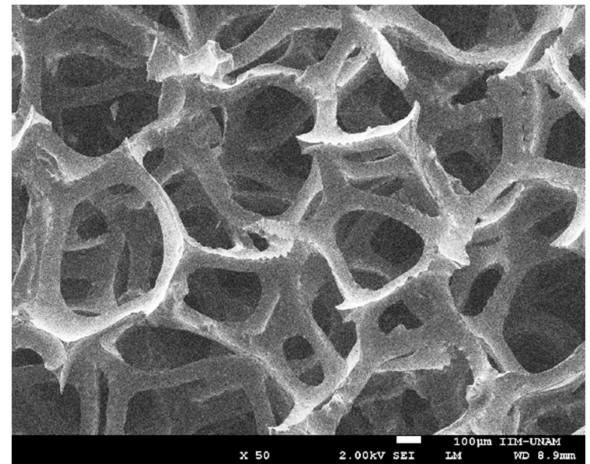
Figure 4. SEM micrograph of reticulated vitreous carbon used as support material.